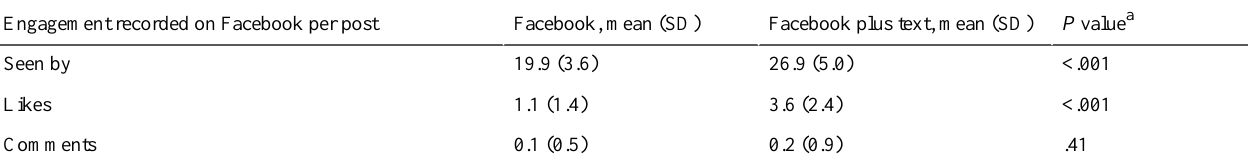
Table 6. Engagement with the program on